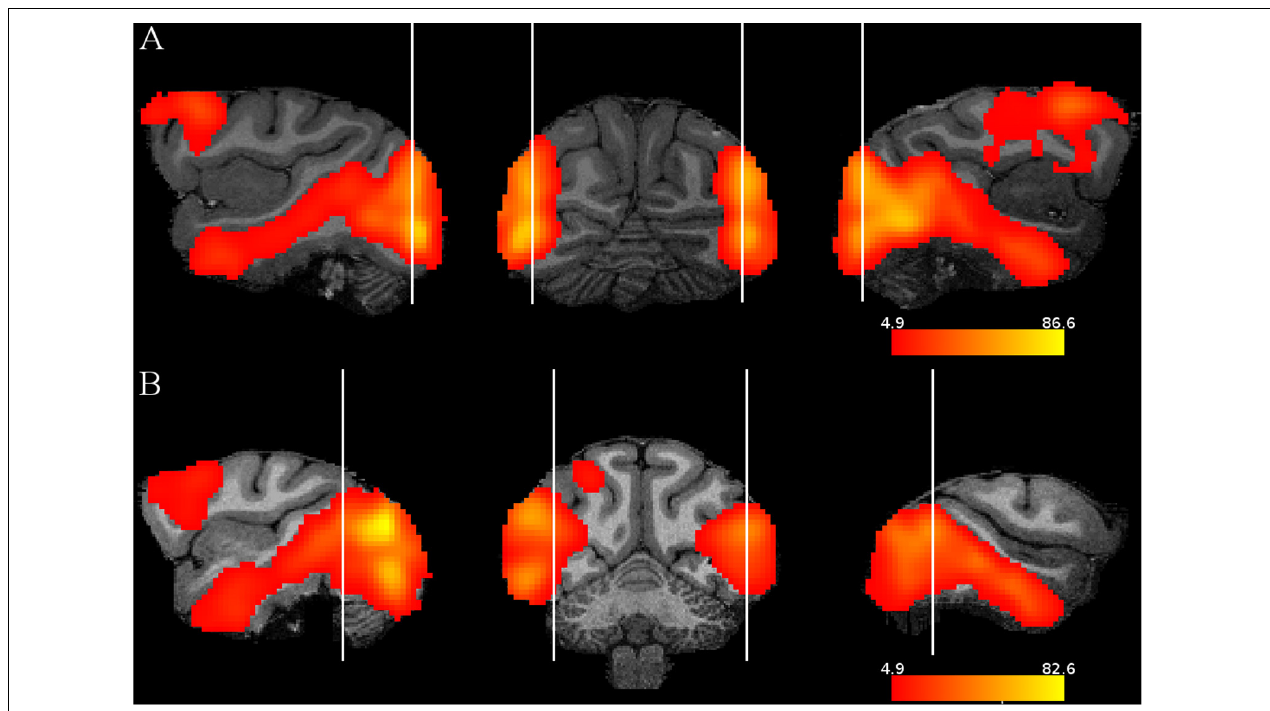
FIGURE 2 | Stimulus activations: contrast random sequence – fixation only. Sagittal and coronal slices illustrating for each monkey and hemisphere the activations by the images compared to a condition in which only the fixation target was presented. The activations are presented on the MRI anatomy of each monkey. The vertical lines indicate where the slices were taken. The color scales indicate t values, thresholded at p = 0.05 family wise error rate. (A) M1, (B)